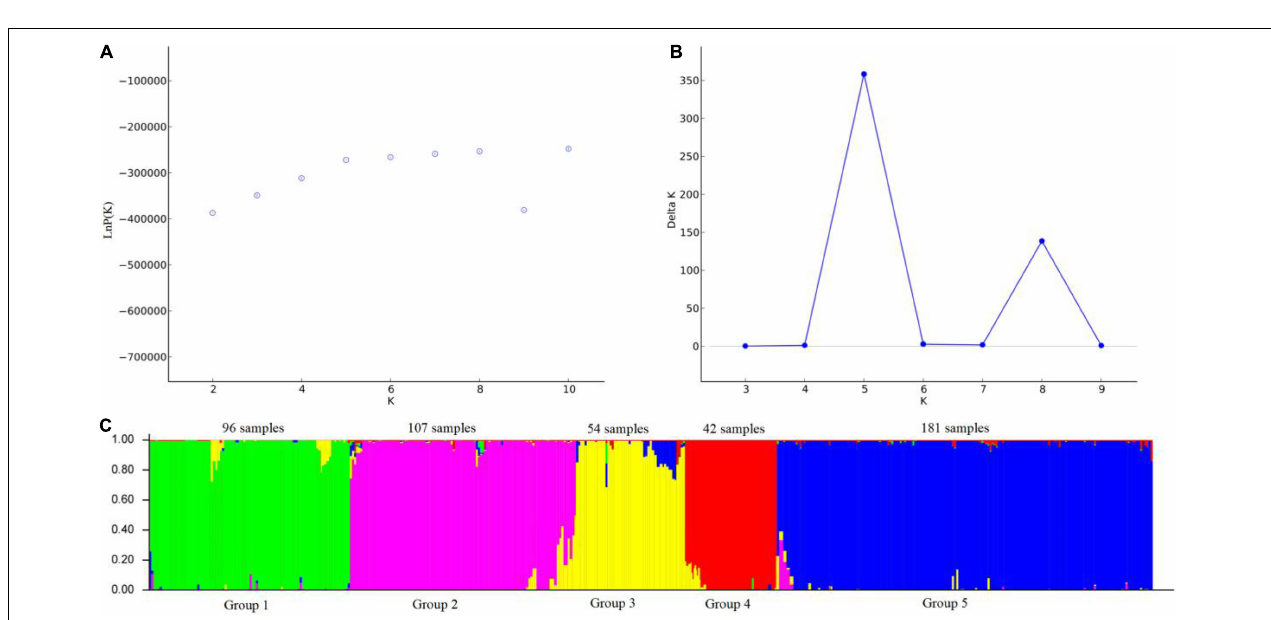
FIGURE 4 | Relationship between genetic distance and geographic distance of 8 Psathyrostachys juncea populations.